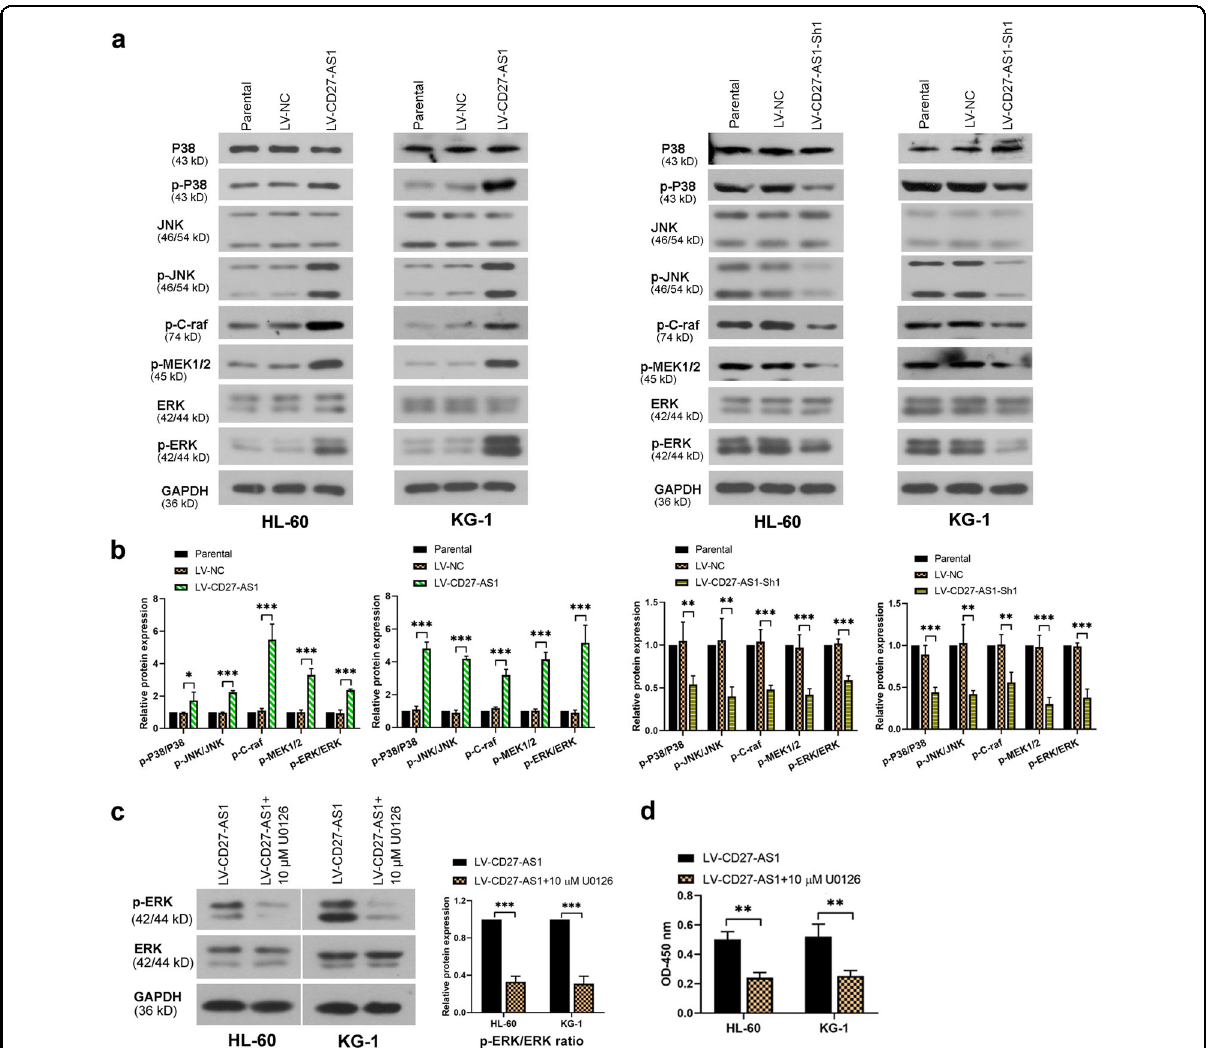
Fig. 5 CD27-AS1 regulates MAPK signaling pathway in the AML cell lines. a HL-60 and KG-1 cells were infected with LV-CD27-AS1 and LV-CD27- AS1-Sh1. Protein levels of P38, p-P38, JNK, p-JNK, p-C-raf, p-MEK1/2, ERK, and p-ERK were detected using western blotting. b Densitometry analysis of protein levels in both cells was performed. c U0126, a MEK1/2 inhibitor, was used to treat the AML cells with CD27-AS1 upregulation. Relative protein levels of p-ERK and ERK were measured using western blotting. d CCK-8 assay was performed to check cell viability. N = 3. Data were shown as means ± SD. * P < 0.05, ** P < 0.01, and *** P <